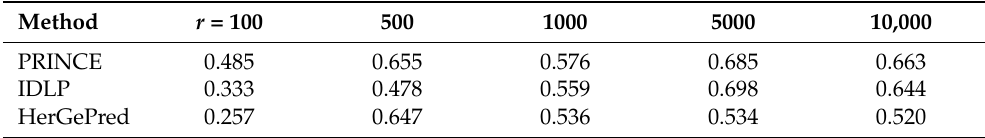
Table 7. AUC results evaluated by gene ranks for disease-gene association prediction without known disease genes from